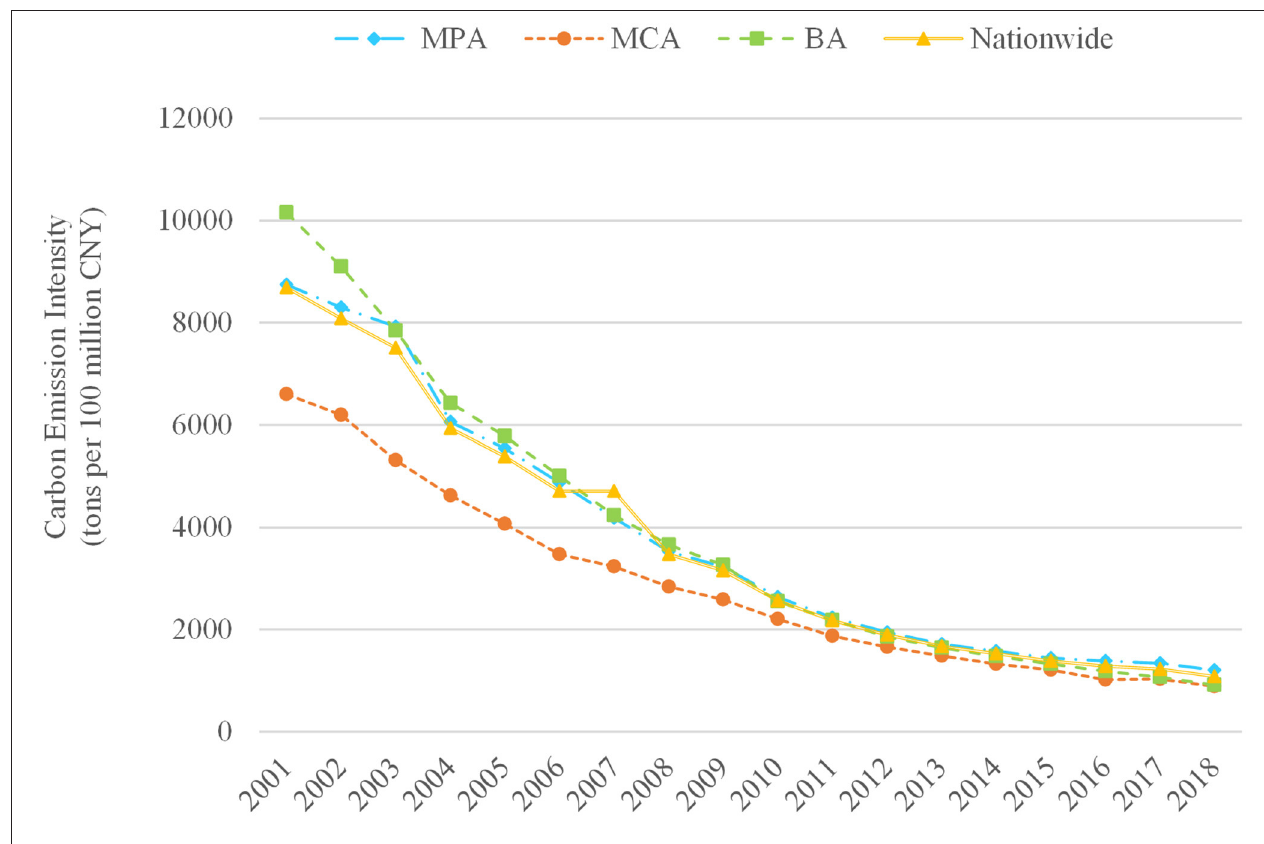
FIGURE 2 | The variation trend of carbon intensity of China’s planting from 2001 to